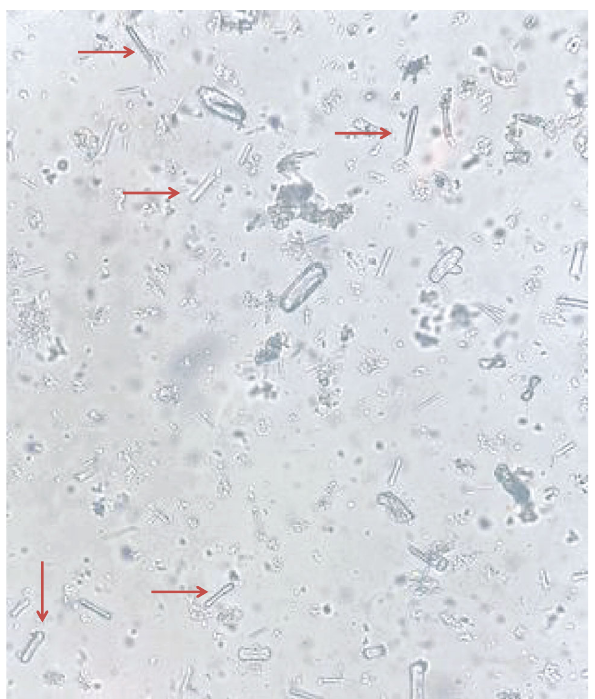
Figure 2: Arrows indicate calcium oxalate monohydrate crystals in this patient ’ s urine sediment, viewed under nonpolarized light microscopy.